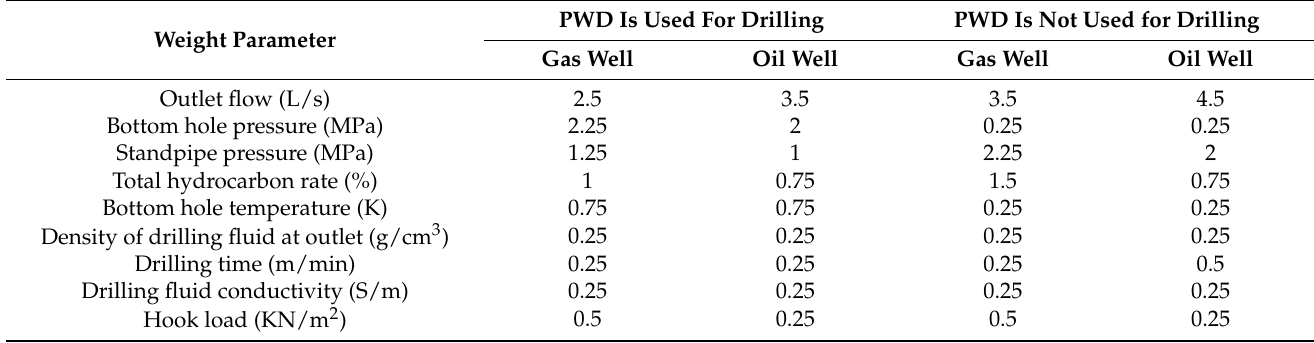
Table 3. Overflow parameters weight setting.